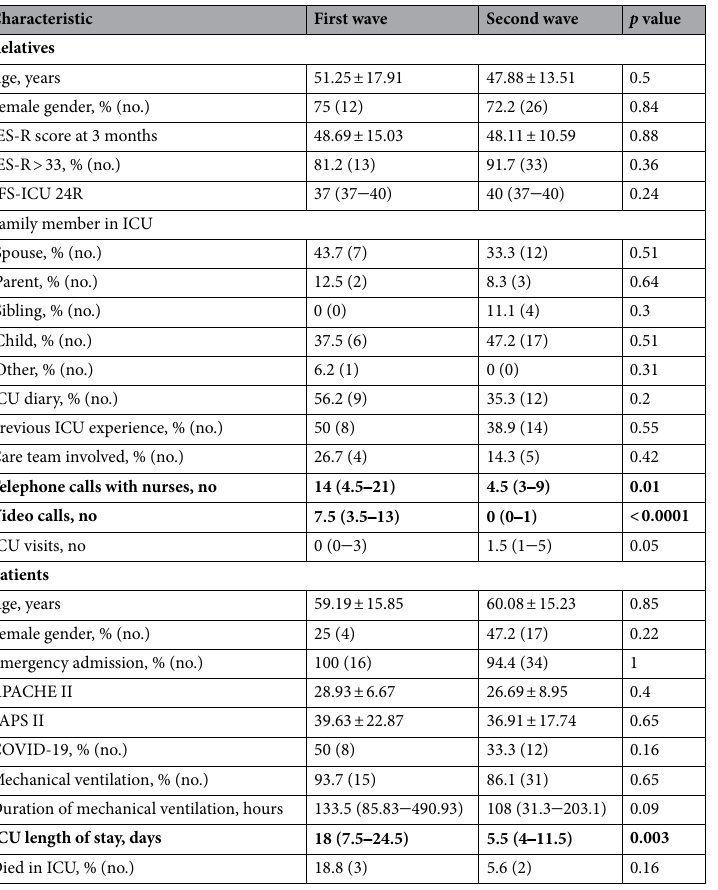
Table 3. Comparison of characteristics in the first and second waves of the COVID-19 pandemic. Significant values are in bold. Relatives’ age, family satisfaction score, patients’ age, duration of mechanical ventilation, and length of stay expressed as median and interquartile range; IES-R score, Acute Physiology and Chronic Health Evaluation II (APACHE II) score, and Simplified Acute Physiology Score II (SAPS II) expressed as mean and standard